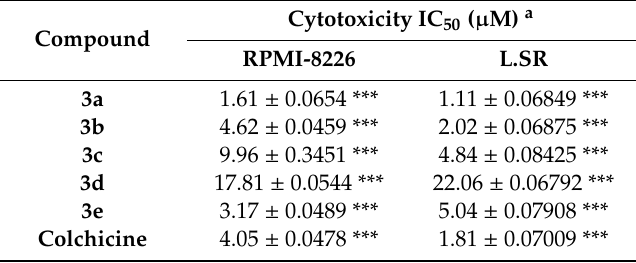
Table 3. MTT assay for the antiproliferative IC 50 ± SD ( µ M) activity of compounds 3a – e and